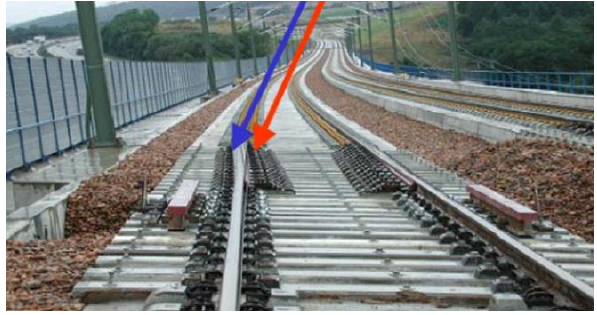
Figure 1. Photo of rail expansion regulator laid on site.